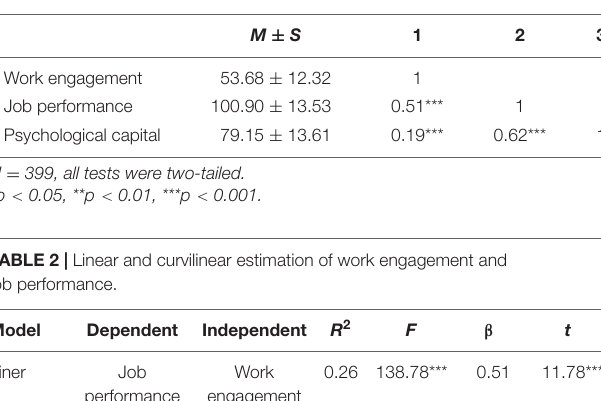
TABLE 1 | Means, standard deviations, and intercorrelations for the key study variables.